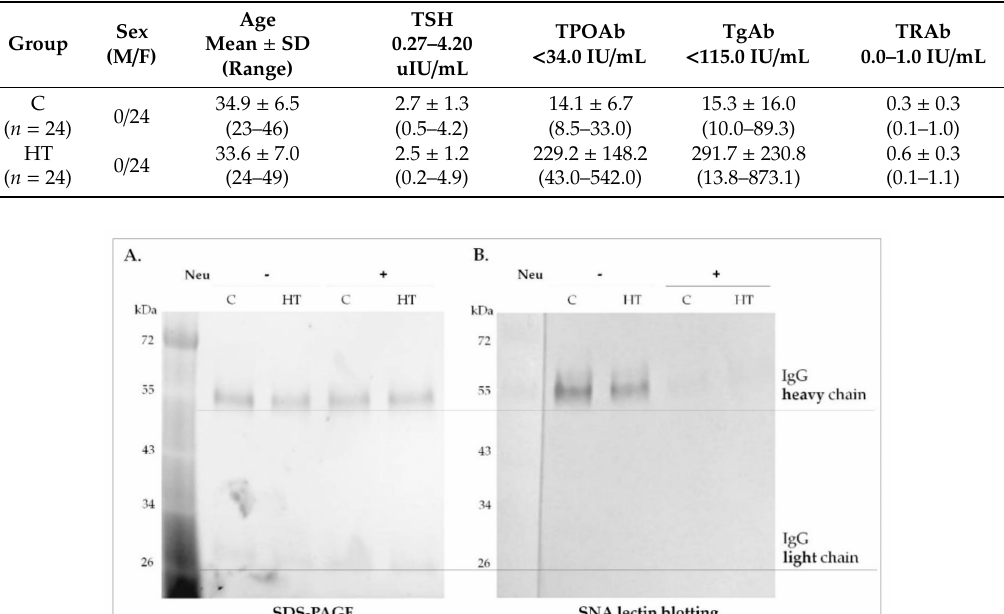
Table 1. Characteristics of Hashimoto’s thyroiditis (HT) and control (C) groups. Data in columns 3–7 are expressed as means ± SD (range). TgAb, thyroglobulin; TPOAb, anti-thyroperoxidase; TRAb,